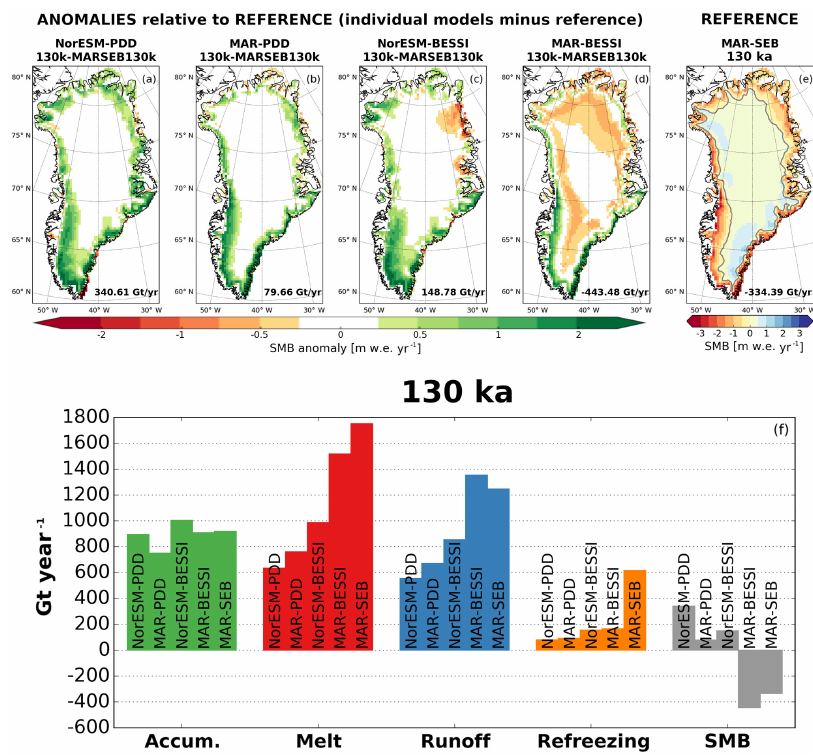
Figure 12. Comparison of the simulated 130ka SMB relative to the 130ka MAR-SEB with all five model combinations. The first row shows the spatial map of SMB for NorESM-PDD (a) , MAR-PDD (b) , NorESM-BESSI (c) , MAR-BESSI (d) , and MAR-SEB (e) , respectively. Our reference, MAR-SEB, is shown in absolute values, while the four simpler models (a–d) are shown as anomalies to MAR-SEB. The total SMB is integrated over all of Greenland (including grid cells with more than 50% permanent ice). The same mask is used for the bar plots (f) . The bar plots show the absolute values for each component of the SMB for the same